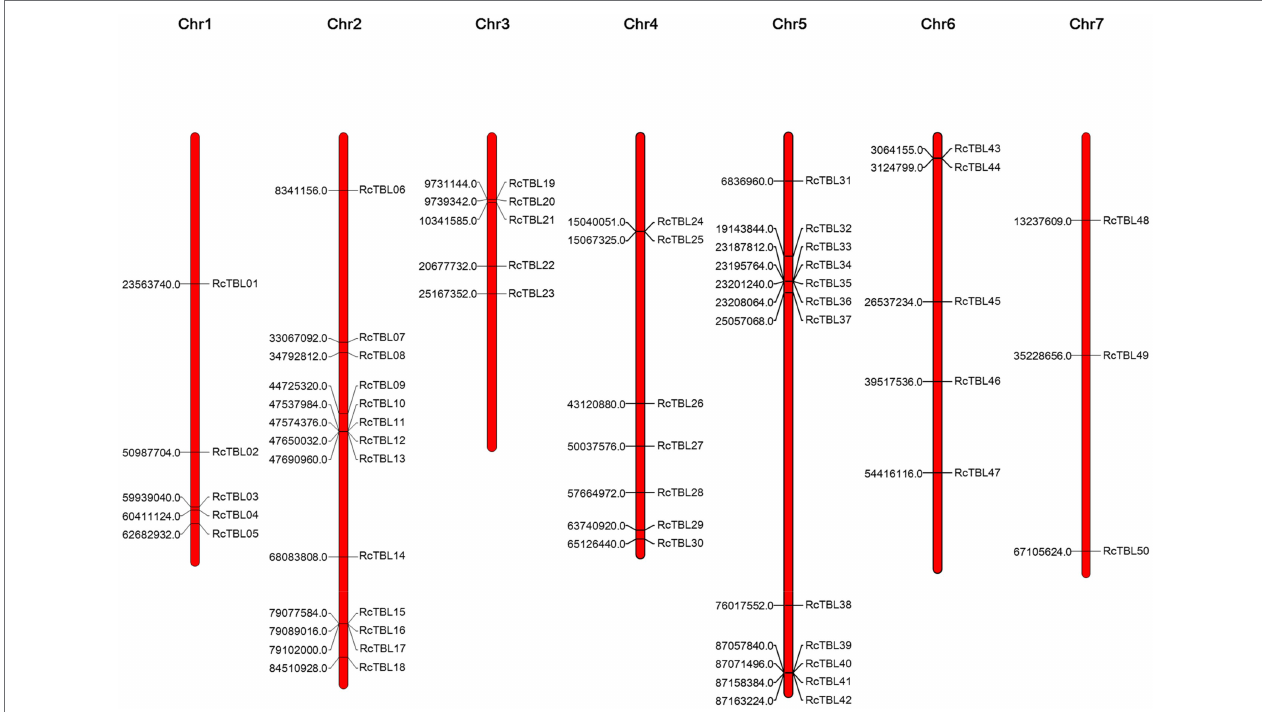
FIGURE 1 | Chromosome localization of rose TBL family members. The distribution of RcTBL s is shown on the seven chromosomes of Rose chinensis . The starting position (bp) of each RcTBL is listed on the left side of the